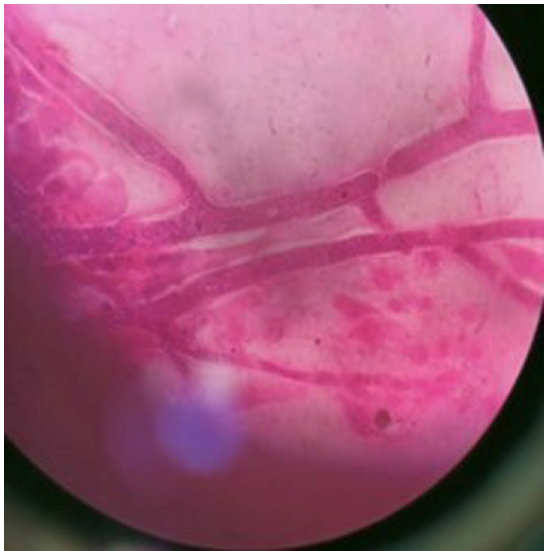
Fig. 2 Histopathological examination of material from nasal scraping showing right-angle branching of aseptate hyphae-suggestive of mucormycosis (done after KOH mount)